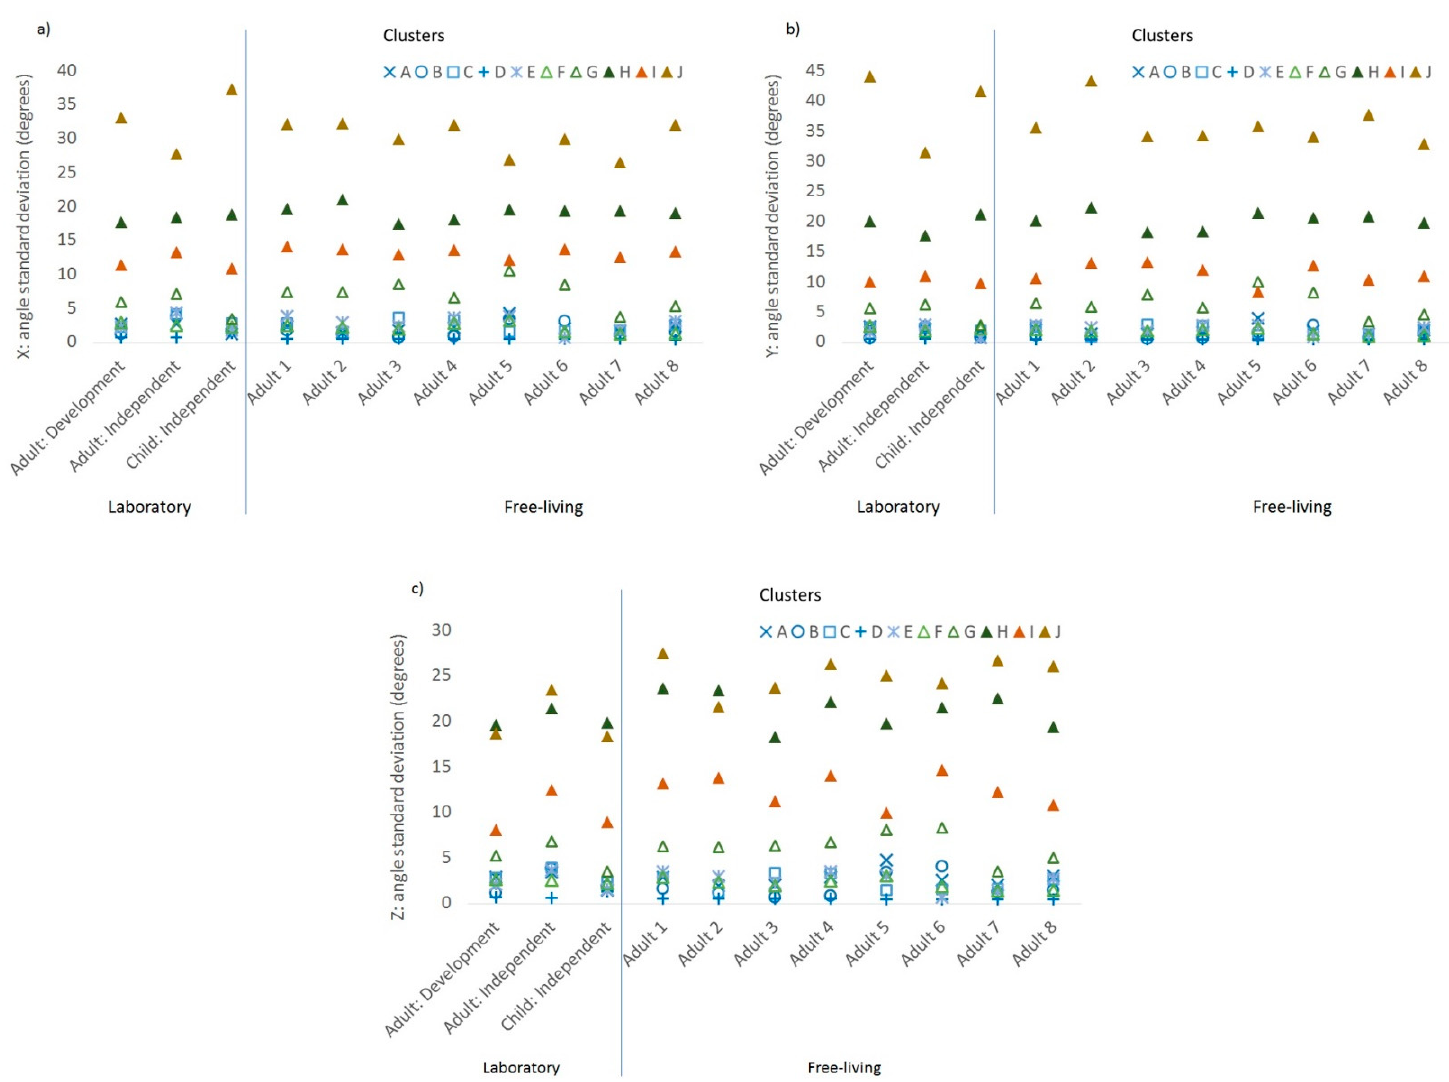
Figure 4. Characteristics of the features with the highest loadings by cluster and by sample, standard deviation of the accelerometer orientation metrics: ( a ) X -axis acceleration relative to the horizontal plane, ( b ) Y -axis acceleration relative to the horizontal plane, and ( c ) Z -axis acceleration relative to the horizontal plane.